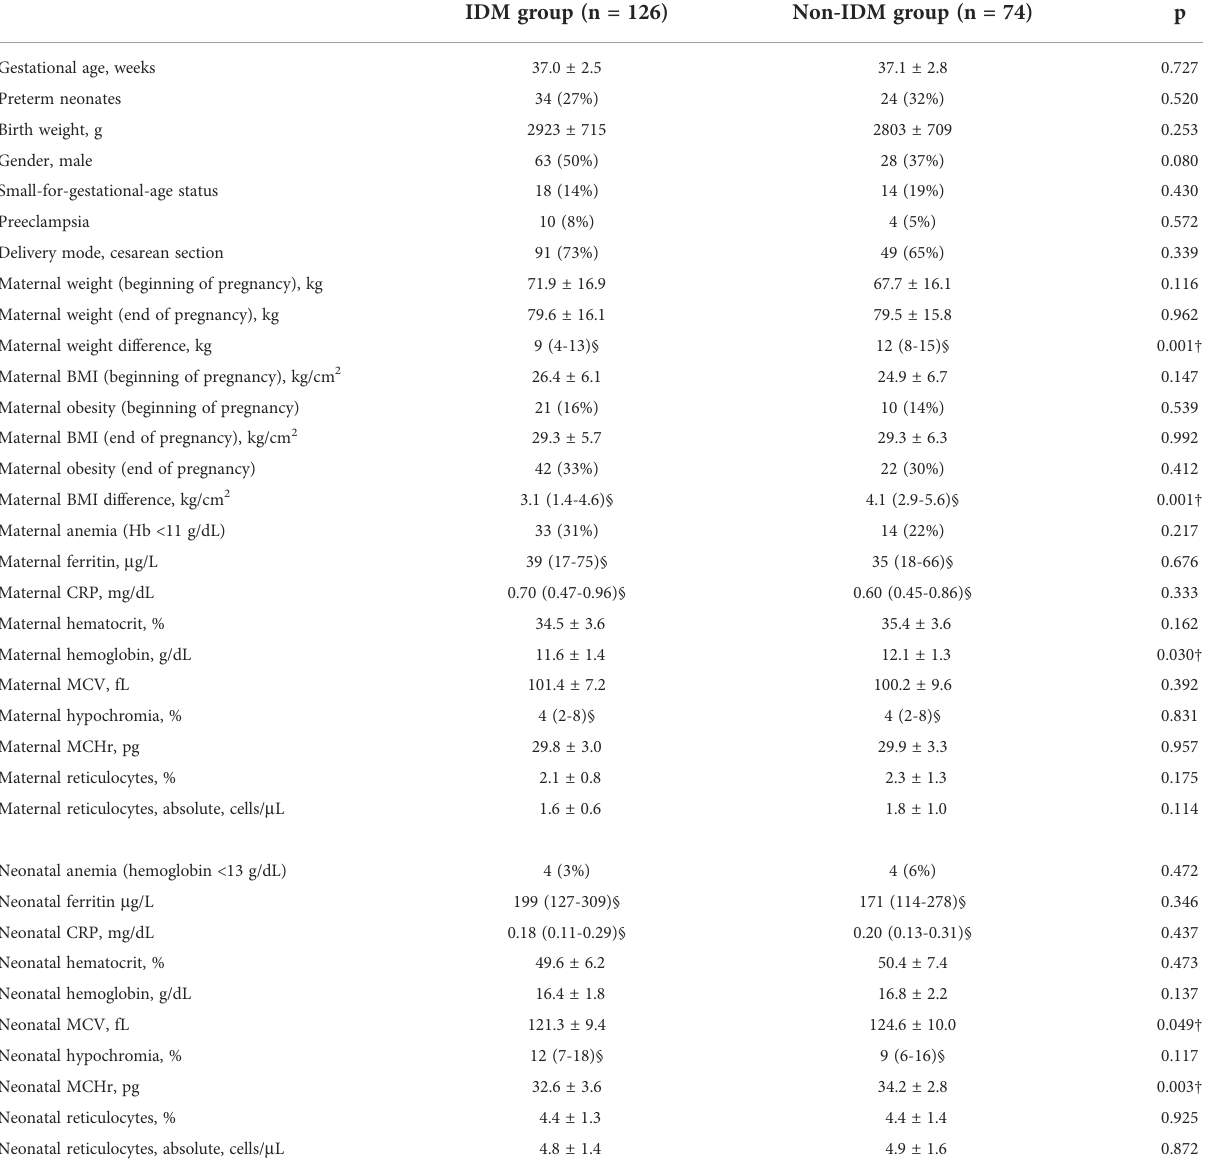
TABLE 1 Perinatal characteristics and hematological indices of the study